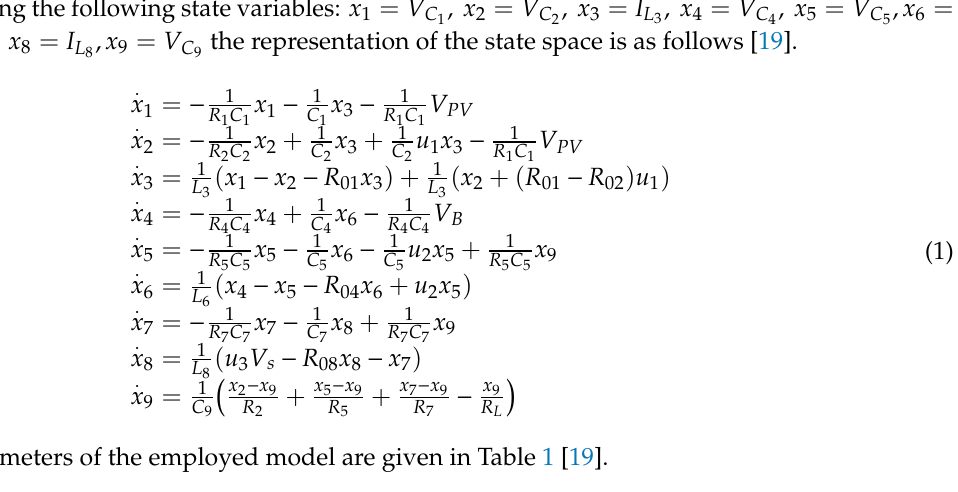
Table 1. Studied direct current (dc) Microgrid